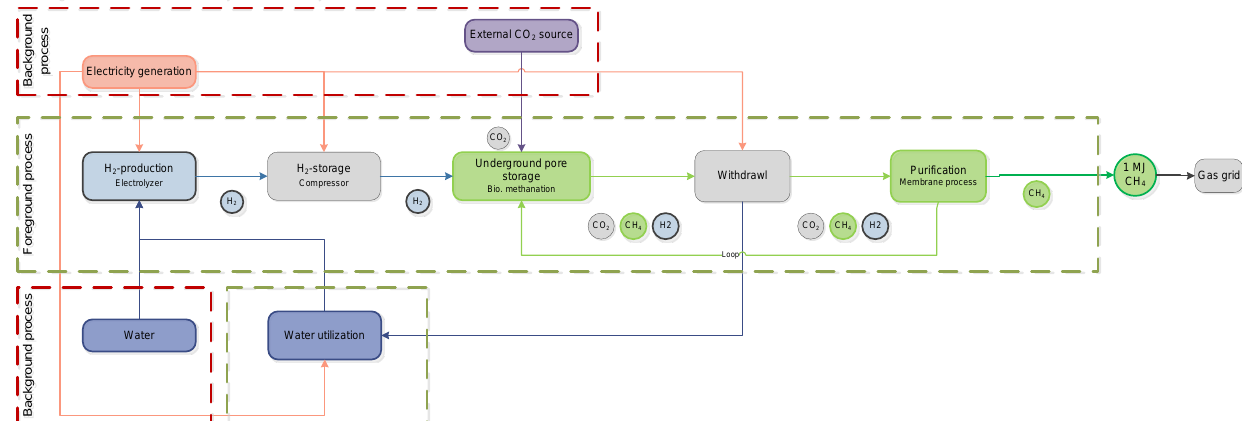
Figure 6. System boundary for the LCA of the Underground Sun Conversion process using the example of the advance scenario.